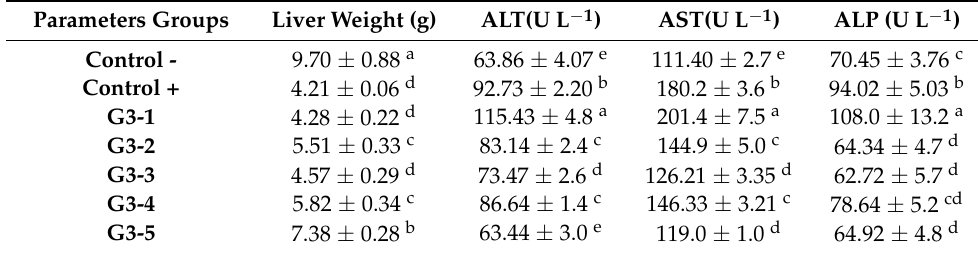
Table 5. Effect of wheat and barley grass on changes in alanine aminotransferase and aspartate aminotransferase, alkaline phosphates, and liver weight in rats exposed to toxic metals (mean ± SD).